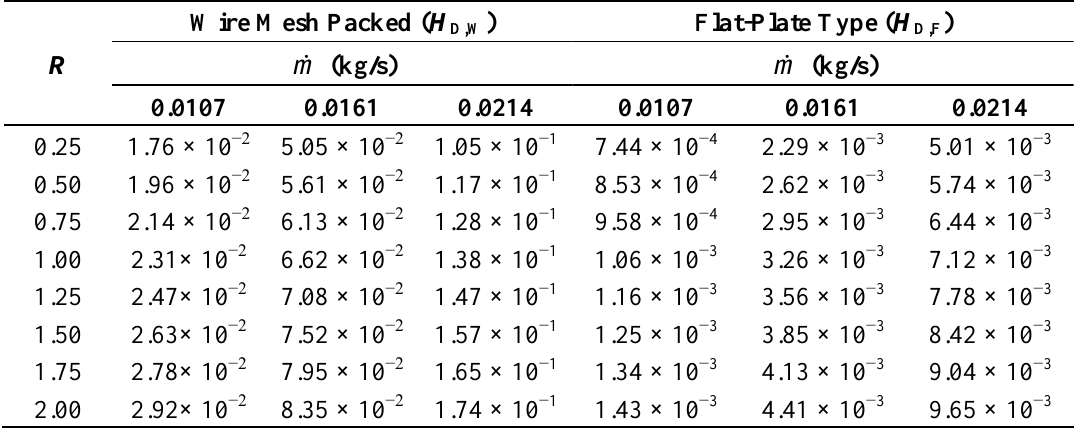
Table 5. The power consumption with recycle ratio and air mass flow rate as